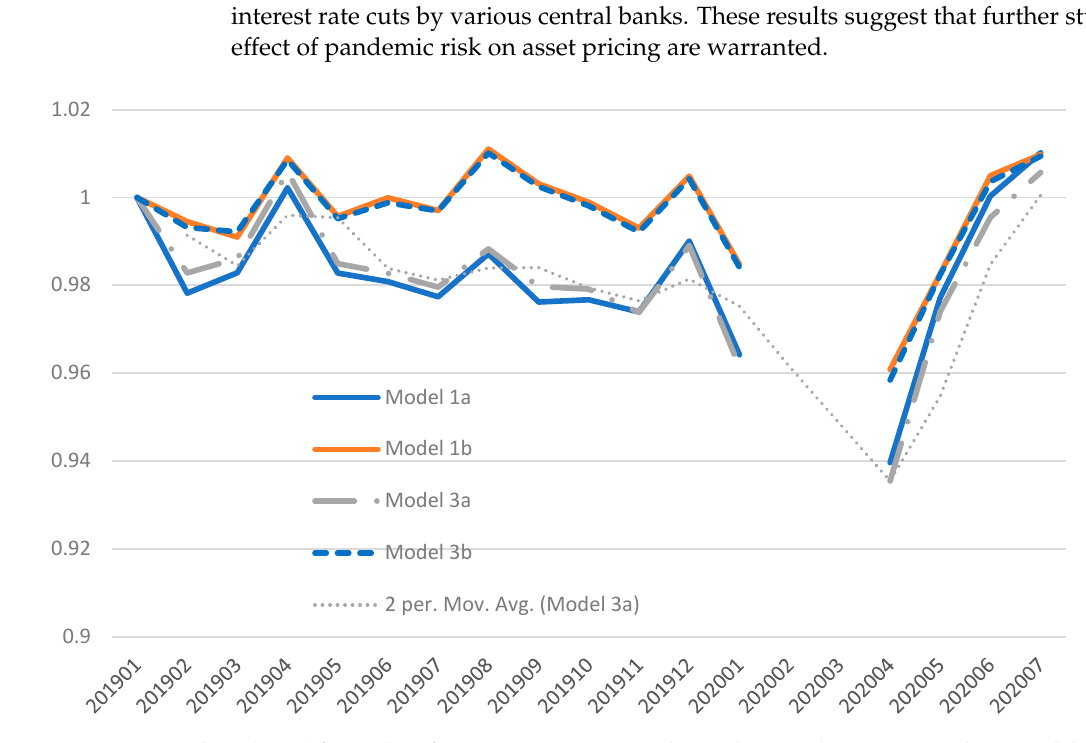
Figure 3. House price indices (HPIs) for Wuhan from 2019M1 to 2020M7 by Hedonic and Distance Gradient Models. Notes: The house price indices estimated by the HEDONIC and DISTANCE Models are shown. The continuous dotted curve refers to the two-period moving average of the estimates of Model 3a, excluding the effect of the two-month lockdown period.